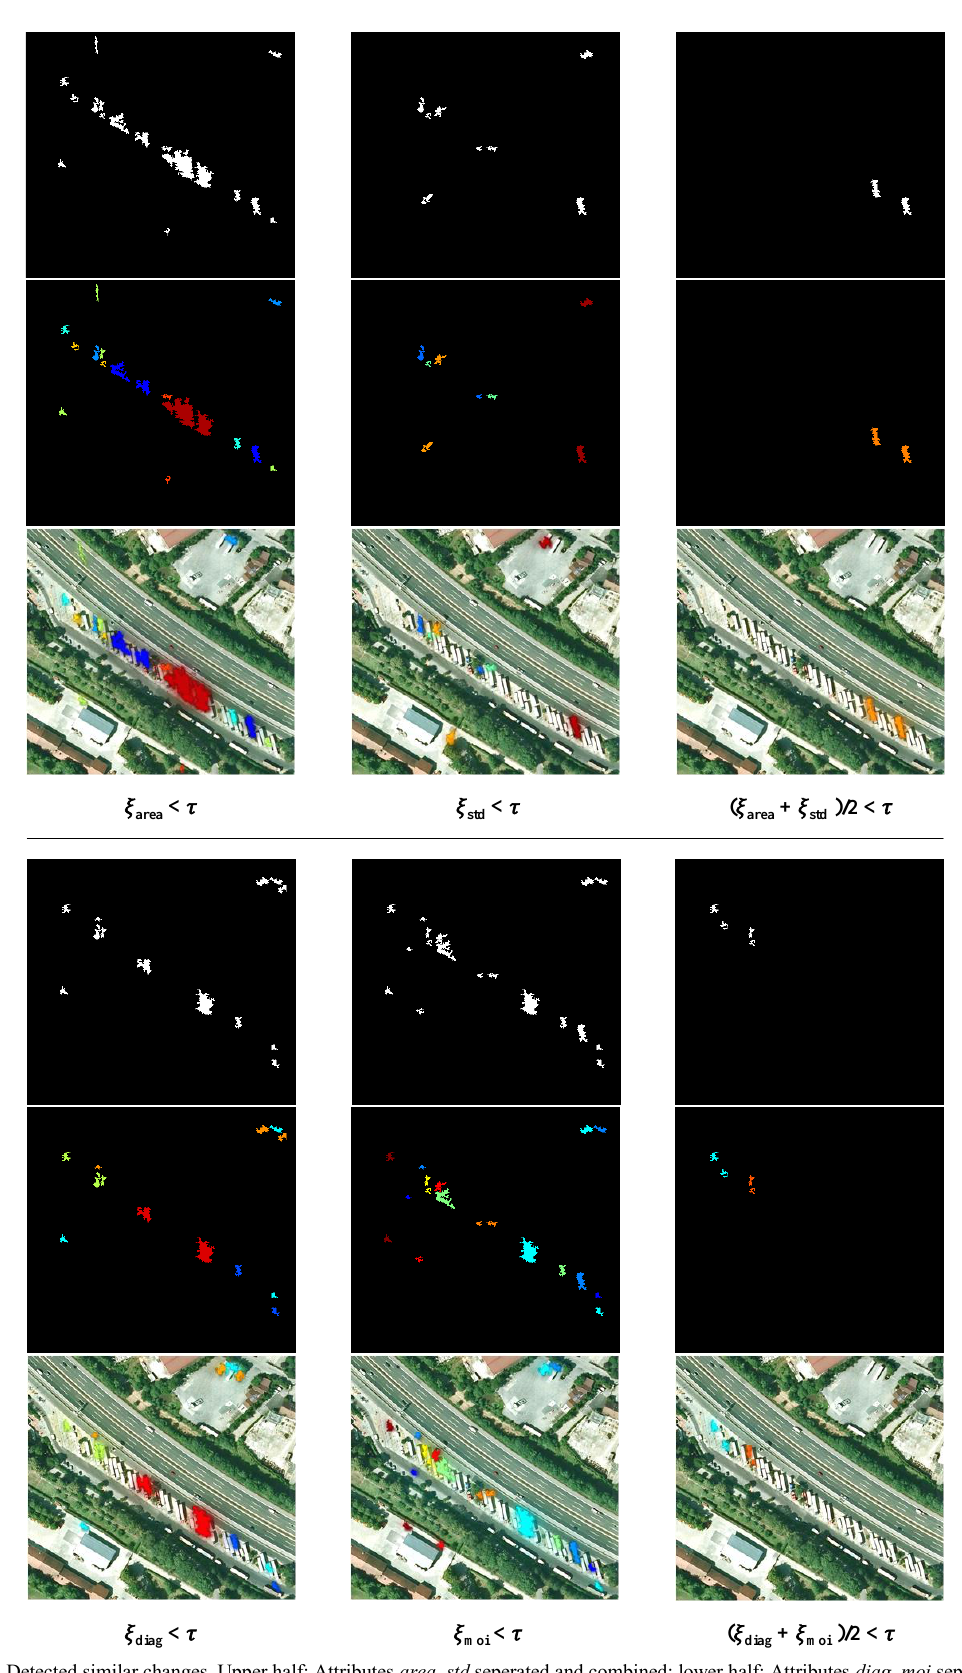
Figure 3: Detected similar changes. Upper half: Attributes area , std seperated and combined; lower half: Attributes diag , moi seperated and combined. Upper and lower half: Detected similar changes (upper row), detected similar changes color-coded (center row), detected similar changes color-coded visualized as overlay image in Google Earth (lower row). Additionally, clusters of similar changes containing at least two segments are random color-coded, where each cluster gets one